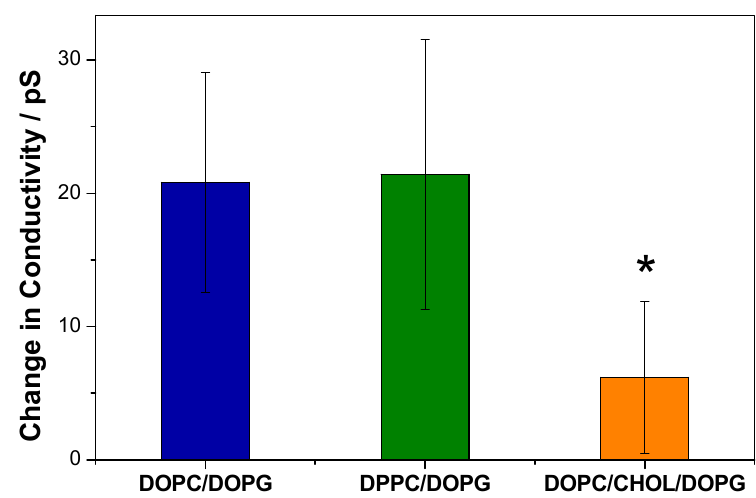
Figure 3. Increase in conductivity of black lipid membranes (BLMs) of the indicated compositions after addition of 1 μ M KR 9 C. ANOVA test indicated that there is at least one different data with a 5% confidence ( α = 0.05); the obtained * p -value was 0.01. The asterisk denotes a statistically significant difference between 1,2-dioleoyl-sn-glycero-3-phosphocholine (DOPC)/ cholesterol (CHOL)/DOPG and DOPC/DOPG and DPPC/DOP, according to the Tukey test